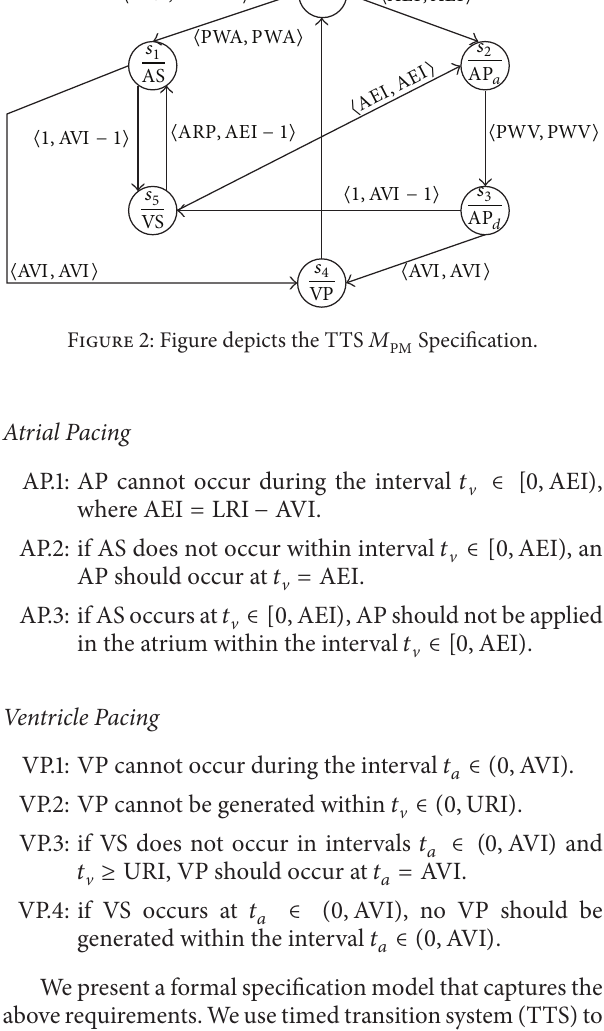
Figure 2: Figure depicts the TTS 𝑀 PM Specification.